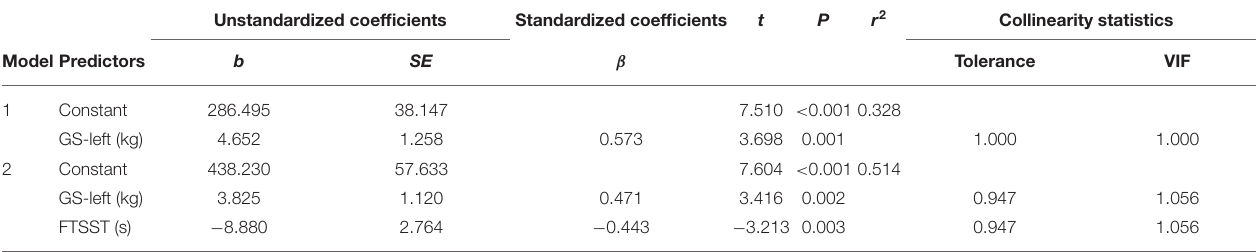
TABLE 2 | The result of multiple linear regression analysis coefficients in the stroke group a